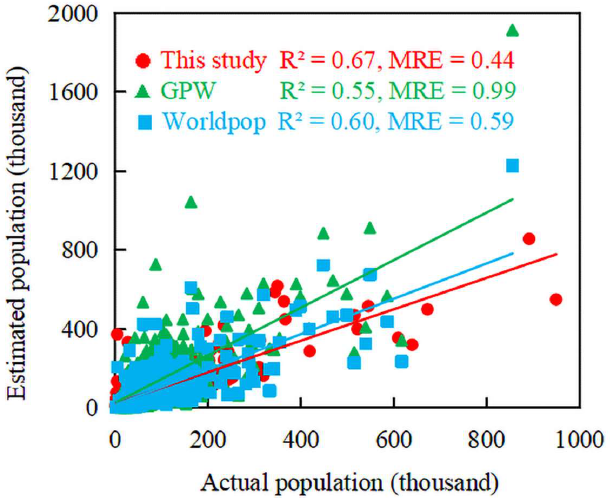
Figure 10. In 2020, the population projections were validated at the township/street level and com- pared with two other datasets (GPW and